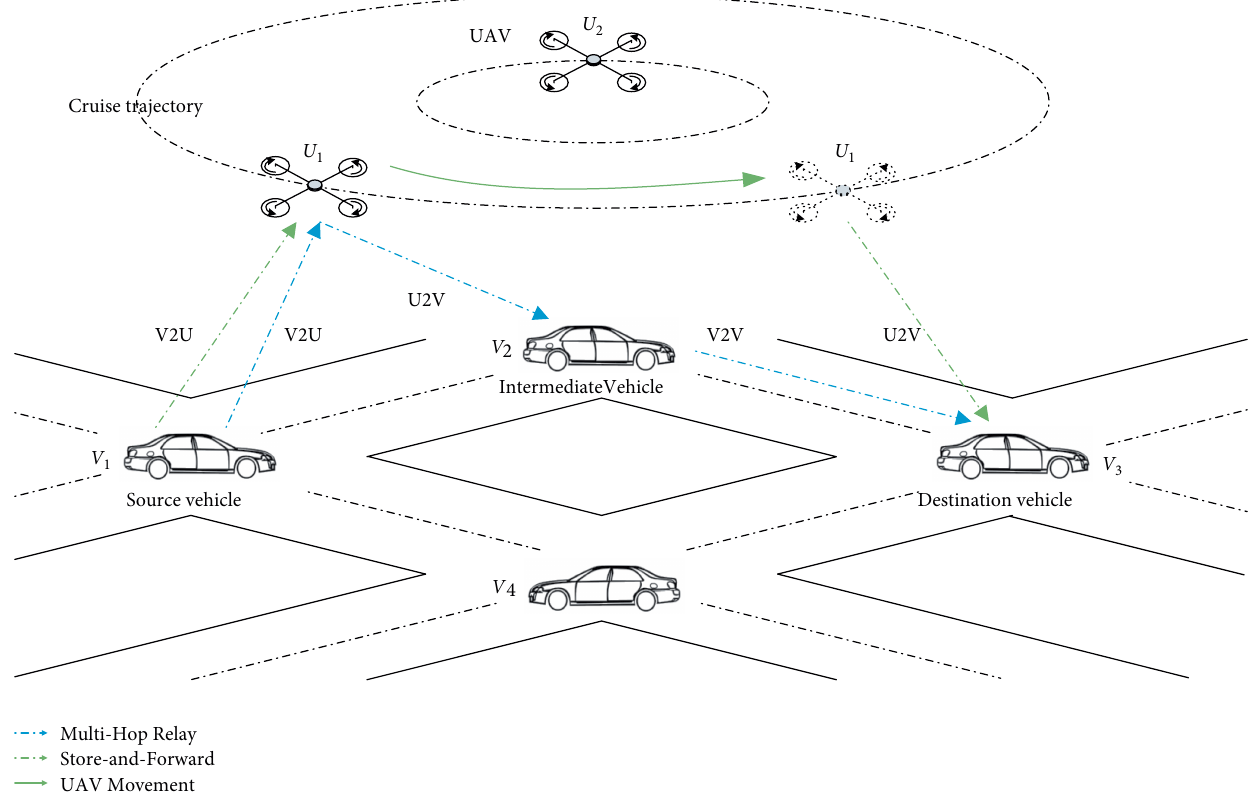
Figure 1: A UAV-assisted data delivery